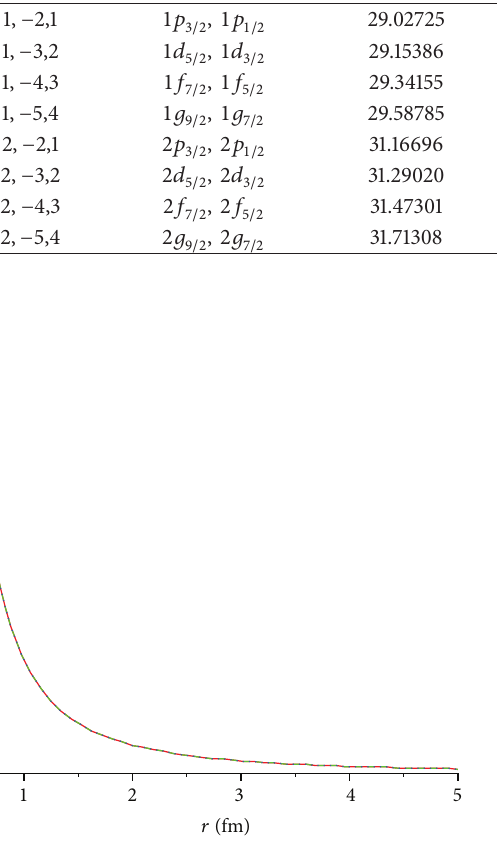
Figure 3: Effect of tensor potential on spin